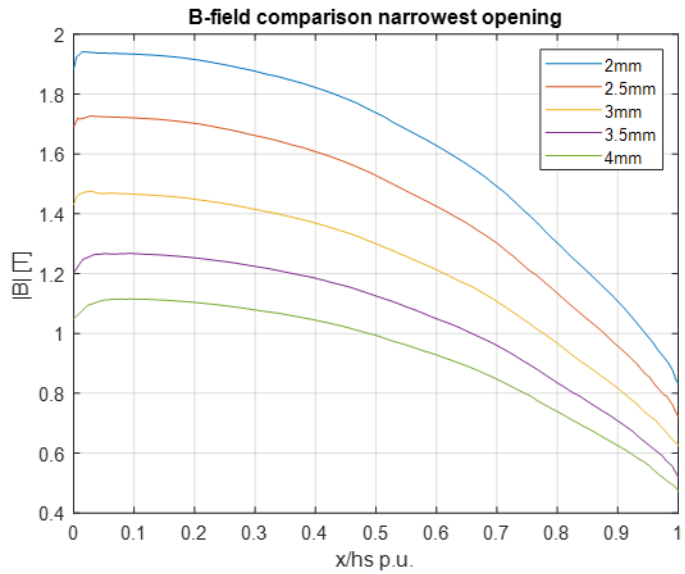
Figure 16. B-field comparison for a trapezoidal slot.